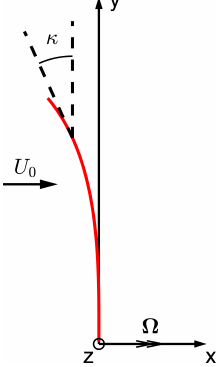
Figure 1. The definition of the coordinate system of the wind tur- bine with only out-of-plane shapes. The x axis is the axial direction, which is positive in the incoming wind direction. The y axis is the radial direction, which is positive in the direction of increasing ra- dius of the blade. The z axis is the tangential direction and is normal to both the x axis and the y axis. Its direction is defined so that a right-handed system is found. The rotation vector (cid:127) is aligned with the x